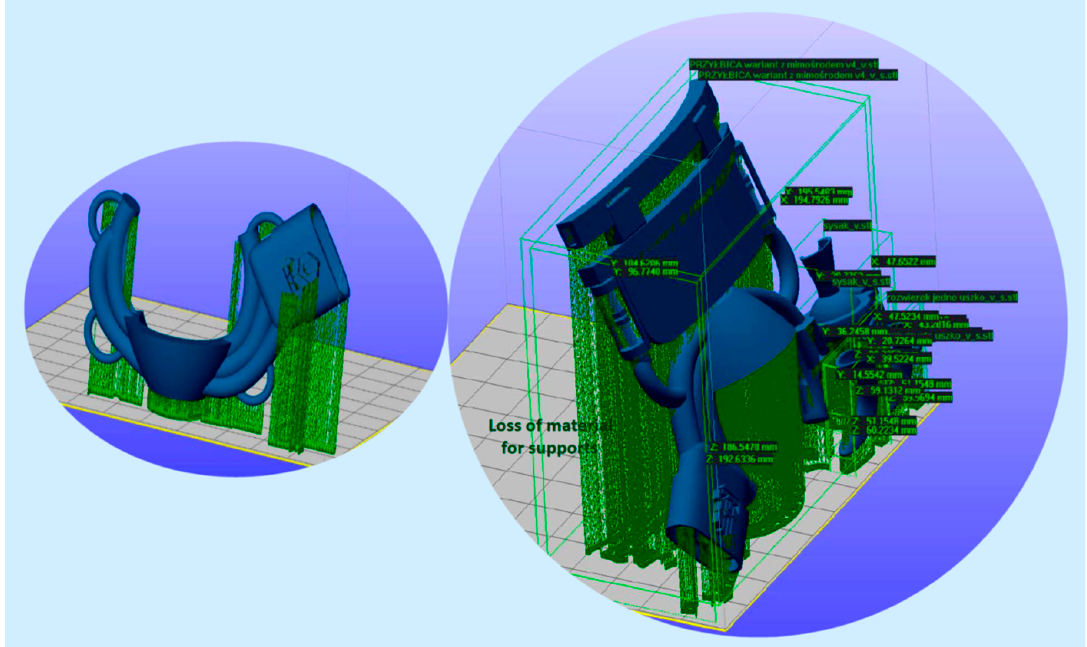
Figure 13. Diagram of the production of basic and advanced face caps using the stereolithography method.